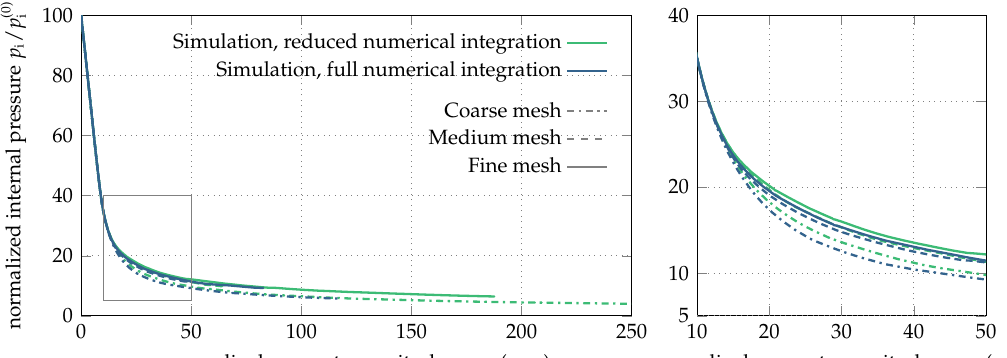
Figure 16. Load–displacement curves: normalized internal pressure versus the mean displacement magnitude at the tunnel surface for the three finite element meshes with full and reduced numerical integration: total view ( left ), detailed view ( right